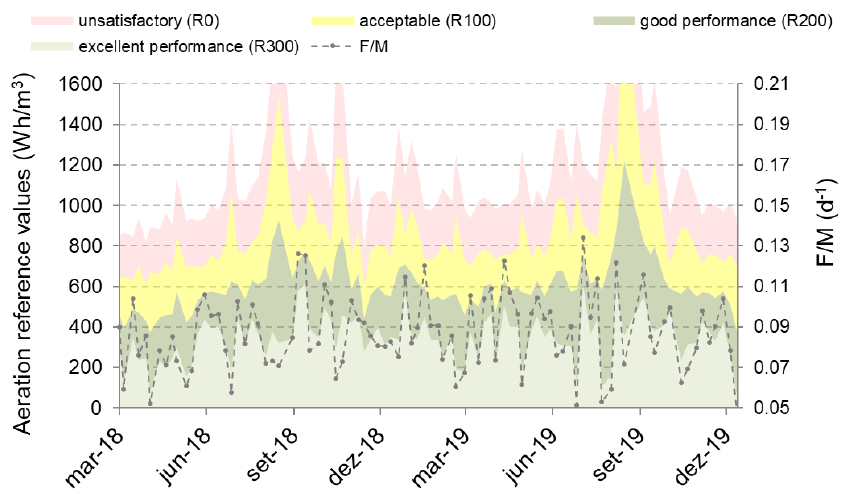
Figure 10. The reference values for energy consumption in aeration over the 1.8-year period analyzed in WWTP K.